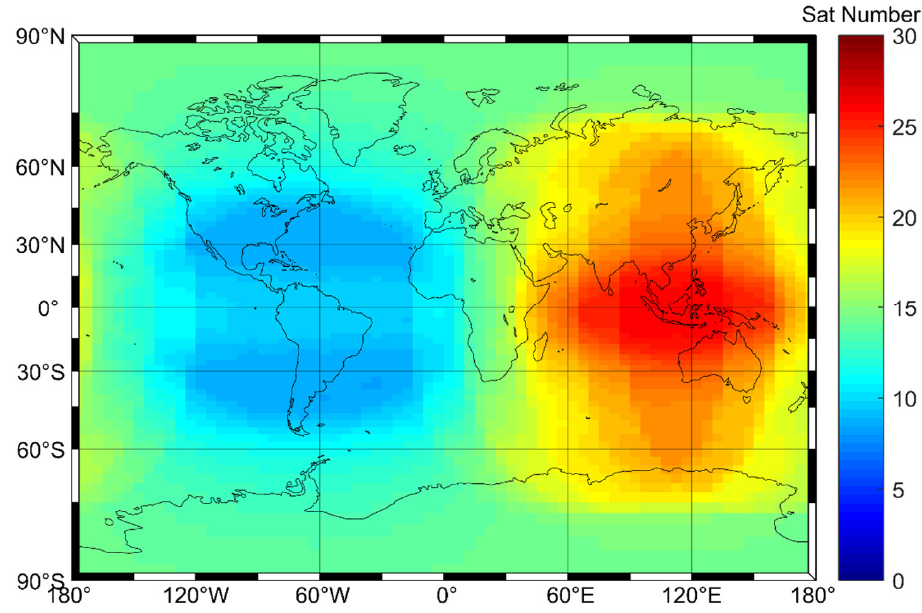
Figure 15. Global distribution of BDS satellite visibility.